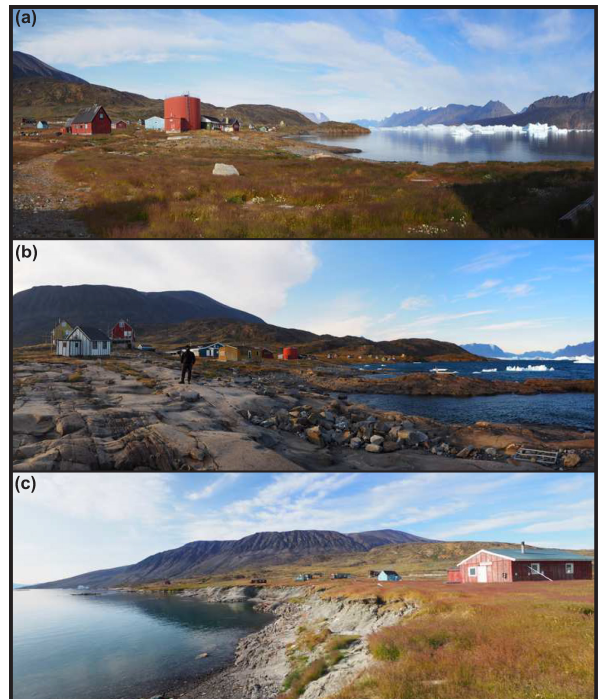
Figure 2. Coastal landscapes in Nuugaatsiaq. (a) Densely vege- tated (grasses and shrubs) coastal lowland with ragged shoreline dissected by rocky capes and coves with narrow beaches. (b) Main headland with exposed glacially scoured bare rock surfaces; note accumulations of boulders in rocky hollows. (c) Cliffed coast in Nuugaatsiaq harbour. Tops of the cliff were eroded and gullied by